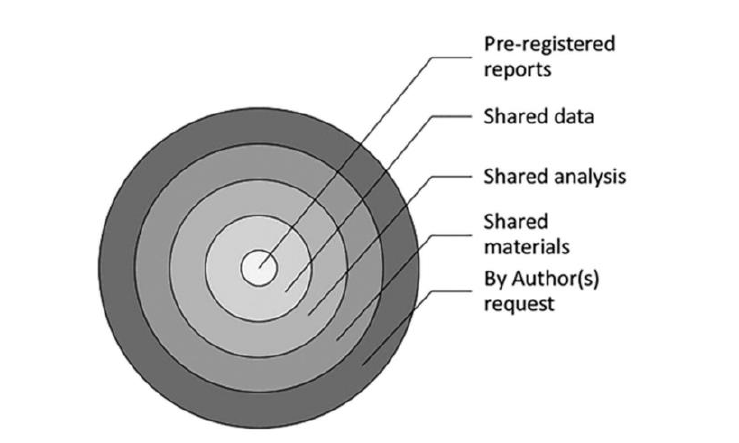
Fig. 1 A conceptual ‘onion model’ for various open science practices. Inner -most layers represent increased transparency for a given published manuscript. Source: Bowman and Keen (2018).